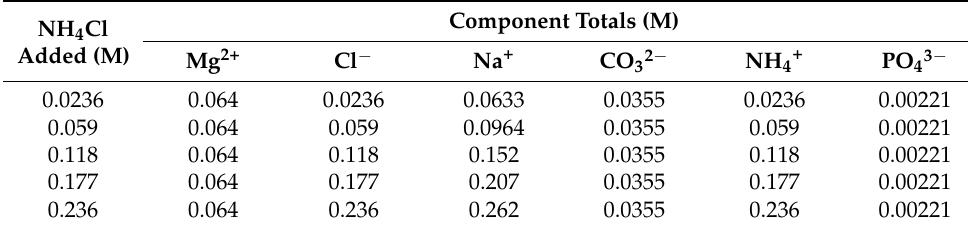
Table A3. MINEQL+ component totals for Mg char at pH 9.